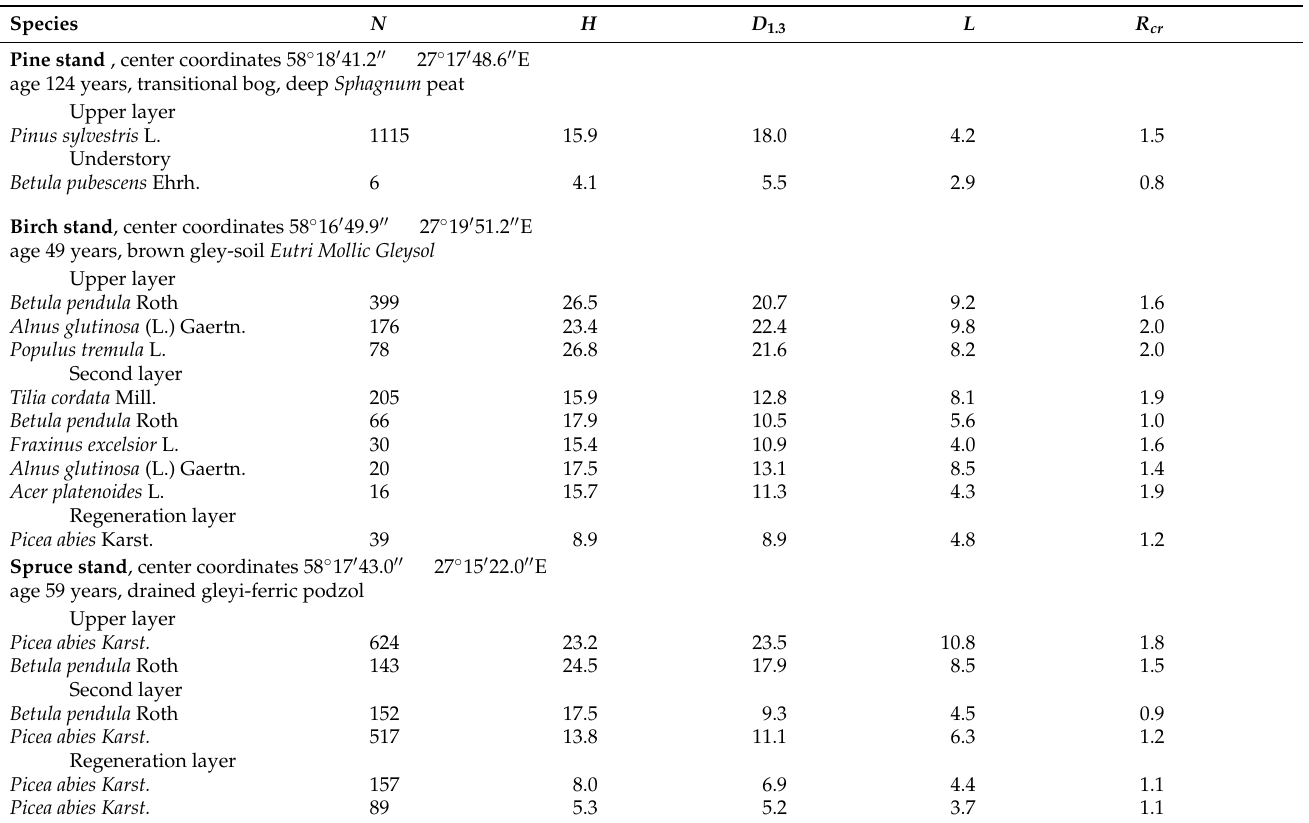
Table 1. Forest stand descriptions.